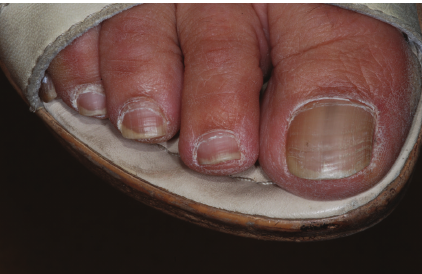
Figure 3: Longitudinal pigmented band on the right great toenail.